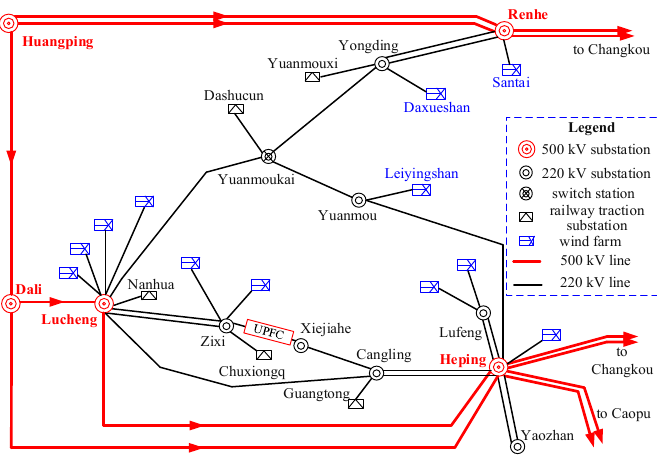
Figure 11. Schematic diagram of Chuxiong Power Grid.